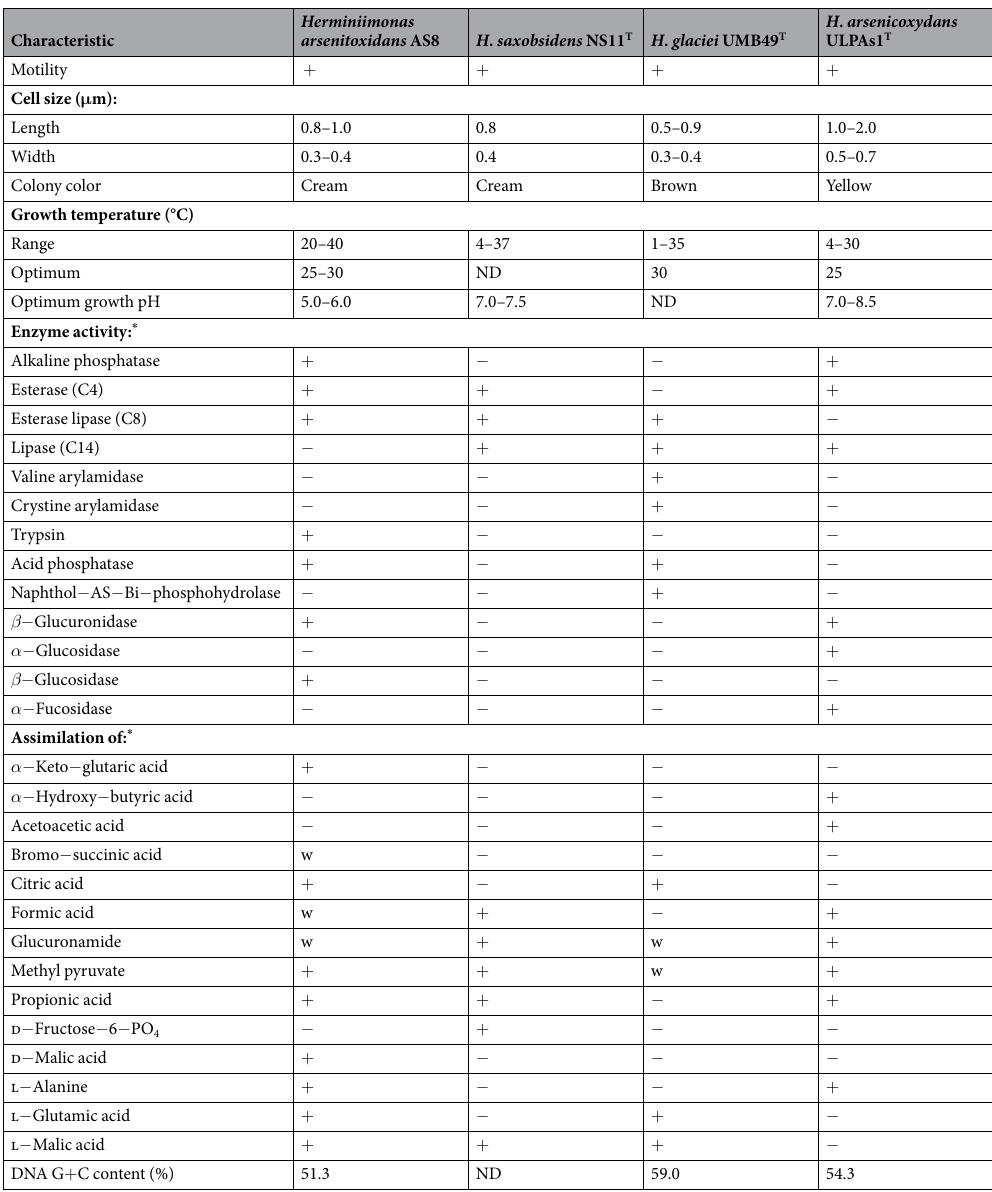
Table 2. The differential characteristics of the novel strain AS8 and of Herminiimonas reference species. All taxa were Gram-negative, and oxidase-and catalase-positive. All strains were positive for leucine arylamidase, l-lactic acid, β -hydroxy-d,l-butyric acid, and acetic acid. All strains were negative for production of urease and indole, α -chymotrypsin, α -galactosidase and β -glucosidase; hydrolysis of esculin ferric citrate and gelatin; fermentation of d-glucose; and utilization of α -d-lactose, α -d-glucose, α -keto-butyric acid, β -methyl-d- glucoside, γ - amino-butyric acid, myo -inositol, dextrin, gentiobiose, sucrose, stachyose, inosine, glycerol, gelatin, pectin, mucic acid, quinic acid, Tween 40, d-maltose, d-trehalose, d-cellobiose, d-turanose, d-raffinose, d-melibiose, d-salicin, d-mannose, d-fructose, d-galactose, d-fucose, d-sorbitol, d-mannitol, d-arabitol,